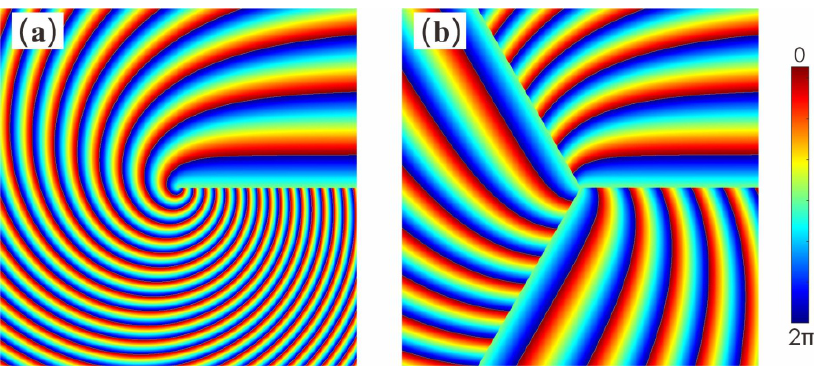
Figure 2. Phase distributions of ( a ) MHCBs with K = 0, m = 1, α = 6 and ( b ) MHCBs with K = 0, m = 3, α =